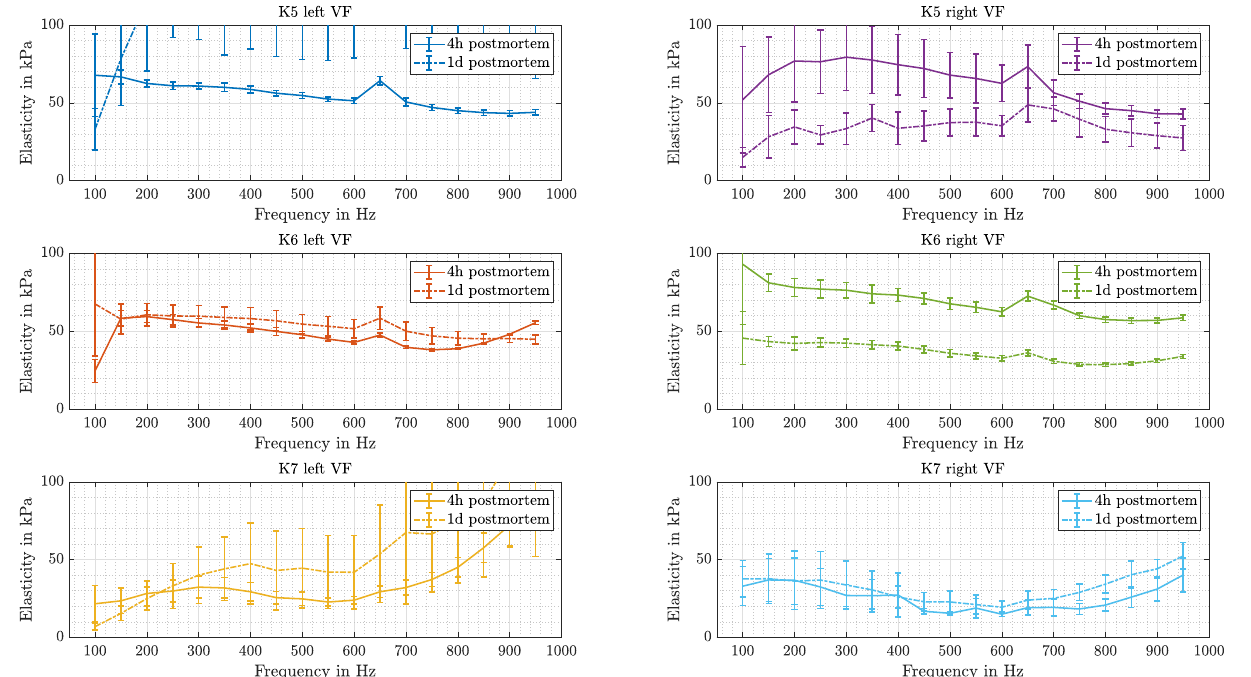
Figure 15. Elasticity changes over time for each sample (K5, K6, K7) and both VF sides are compared (left and right column). Measurements are taken 4h and 1d